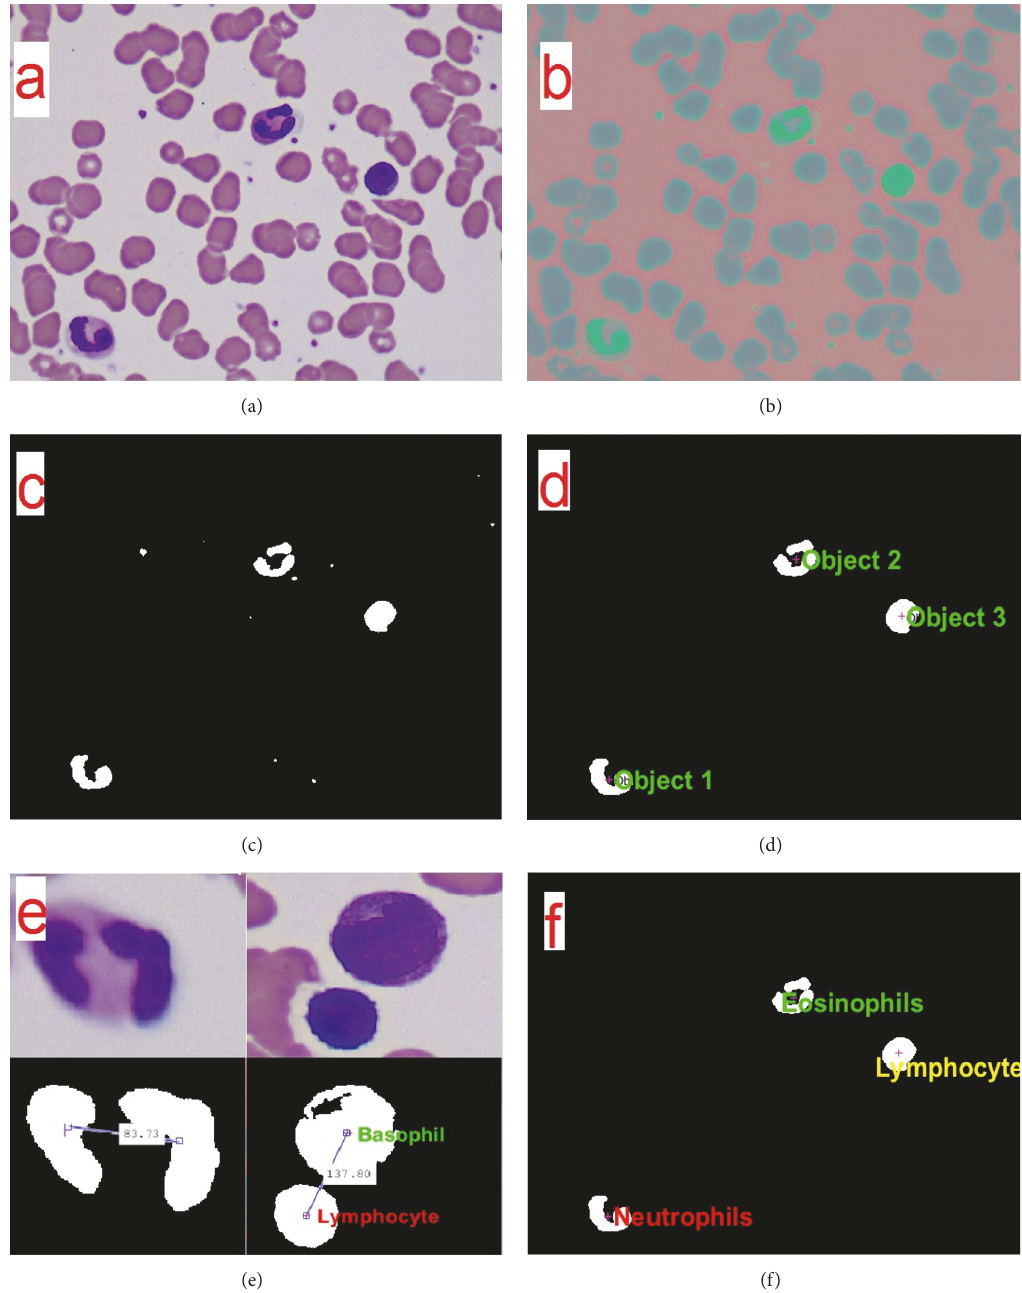
Figure 2: (a) Original Image. (b) Image in YCbCr. (c) Segmentation based on networks of Gaussian radial base functions. (d) Application of morphological operators. (e) Analysis of morphological characteristics. (f) Classification of white blood